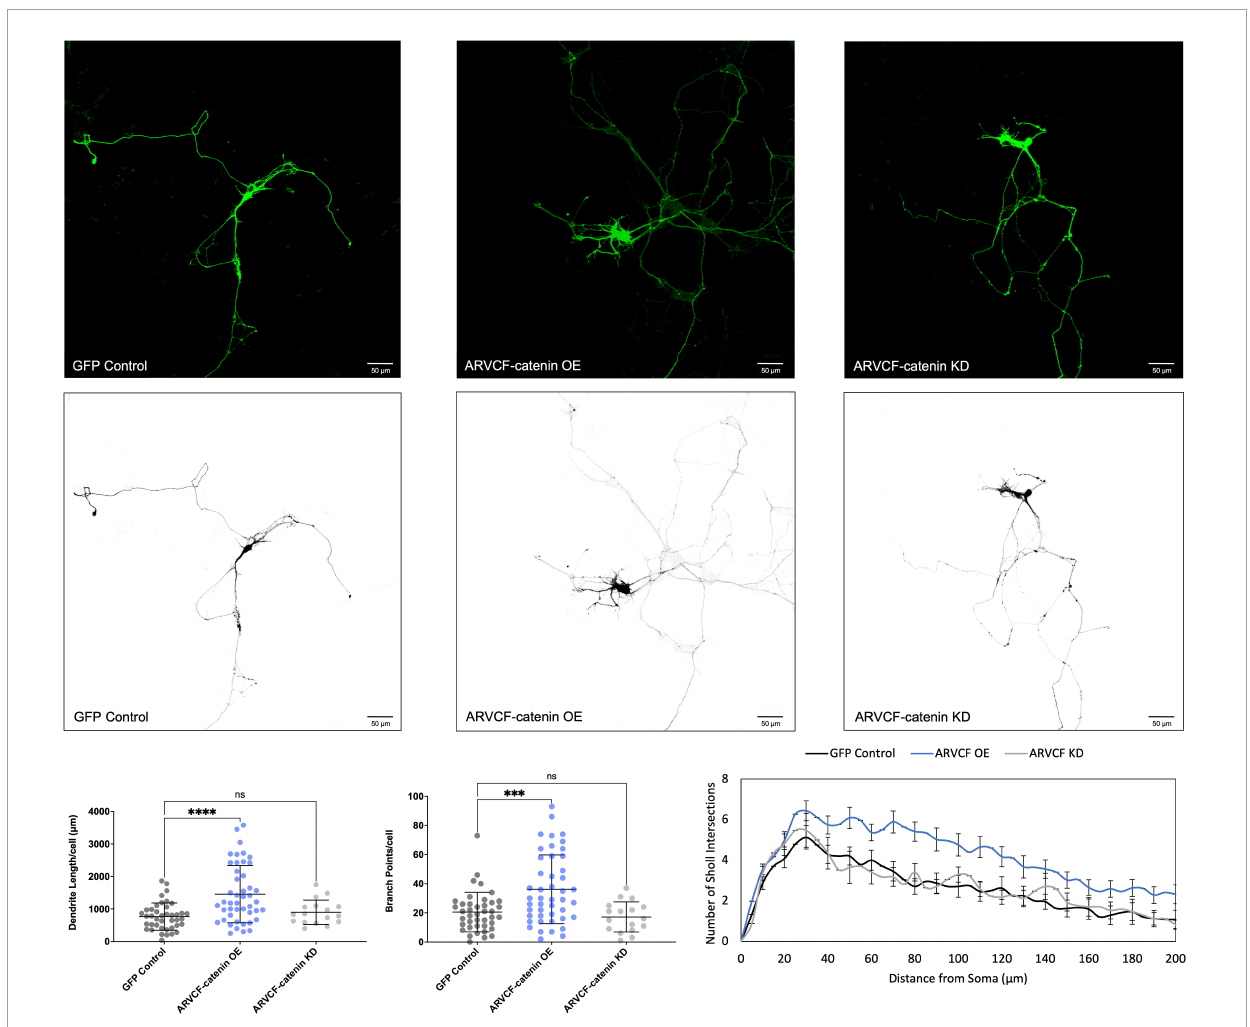
FIGURE5 Morphological effects of ARVCF-catenin expression in developing rat primary hippocampal neurons. Example images are shown of neurons that have been transfected with GFP, exogenous ARVCF-catenin, and shRNA to knockdown ARVCF-catenin. Cells were transfected at 3 DIV and analyzed at 7 DIV. These images have been masked to eliminate other cells in the visual field for clarity. Quantification of the average dendrite length per cell and average number of branch points per cell per each condition are shown below on the left, and Sholl analysis for each condition to the right. The number of cells analyzed in each condition were 46 for ARVCF-catenin OE, 17 for ARVCF-catenin KD, and 41 for GFP control. Samples were taken from five biological replicates. Statistical significance was determined using a two-way Brown-Forsythe and Welch ANOVA tests with Dunnett’s T3 multiple comparisons post-hoc test. Significance was assigned at P < 0.001 for ***, P < 0.0001 for ****, and ns for non-significant. Chart values show mean and standard